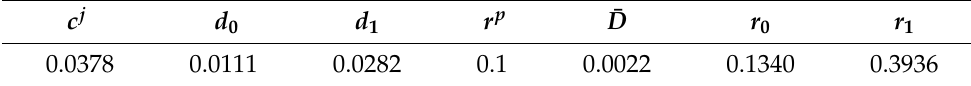
Table 7. Parameters for Deposits (51) and Reserves